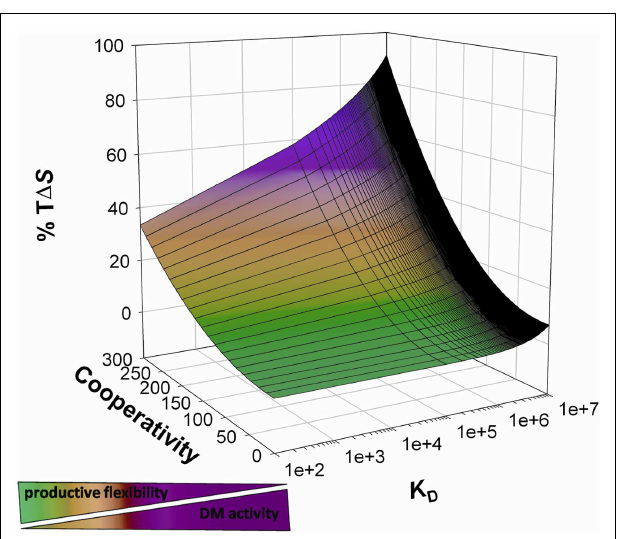
FIGURE 1 |Thermodynamic model of peptide binding and DM action . The probability of a peptide binding to a given HLAII correlates with the probability of the interplay between cooperativity and compensation (here indicated as entropic contribution to free energy decrease) resulting in the optimization of all the available interactions. DM interacts with complexes featuring residual high entropy, promotes peptide release, and skews the presented peptide repertoire toward highly enthalpic complexes by increasing the effective free energy threshold for